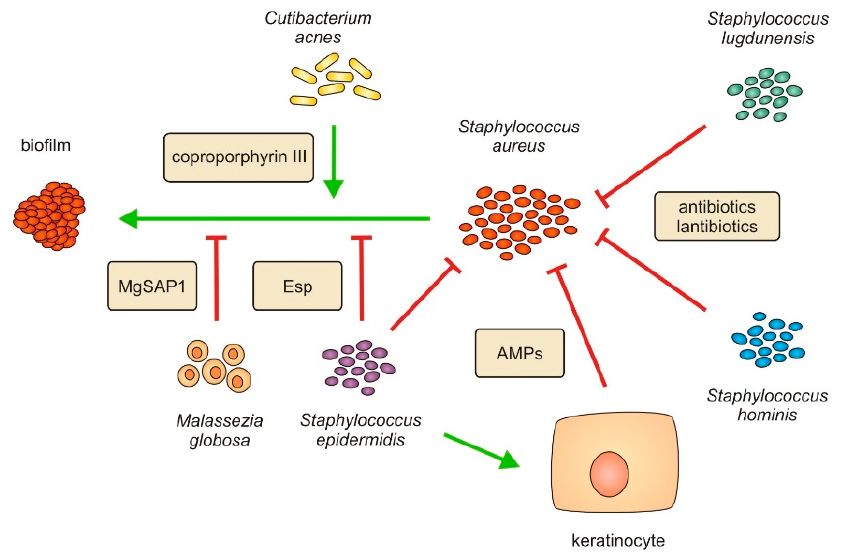
Figure 4. Interplay between Staphylococcus aureus and skin microbiota. Several members of Staphylococcus genus inhibit S. aureus growth and biofilm formation. Staphylococcus lugdunensis and S. hominis suppress colonization of S. aureus by secreting antibiotics and lantibiotics. S. epidermidis induces keratinocytes to produce anti-microbial peptides (AMPs) to eradicate S. aureus , as well as produces protease glutamyl endopeptidase (Esp) which inhibits formation of S. aureus biofilm. The MgSAP1 protease secreted by Malassezia globosa was shown to have a similar effect of disrupting S. aureus biofilm. In contrast, Cutibacterium acnes and its corpoporphyrin III molecule promote S. aureus activity and aggregation, thus inducing S. aureus biofilm formation.